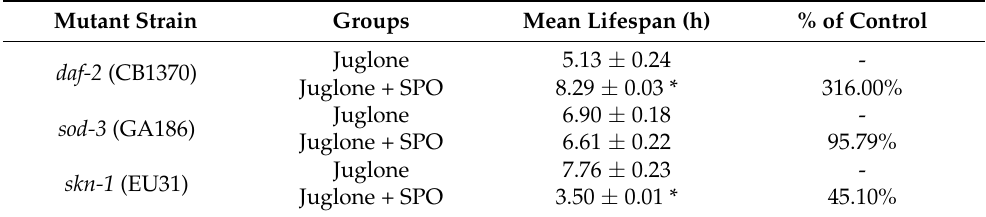
Table 5. Effect of SPO on the oxidative stress of mutant strain induced with